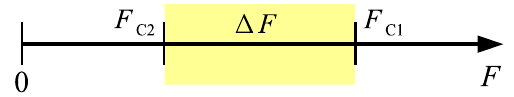
Figure 8. Graphical representation of critical force range, ∆ F .